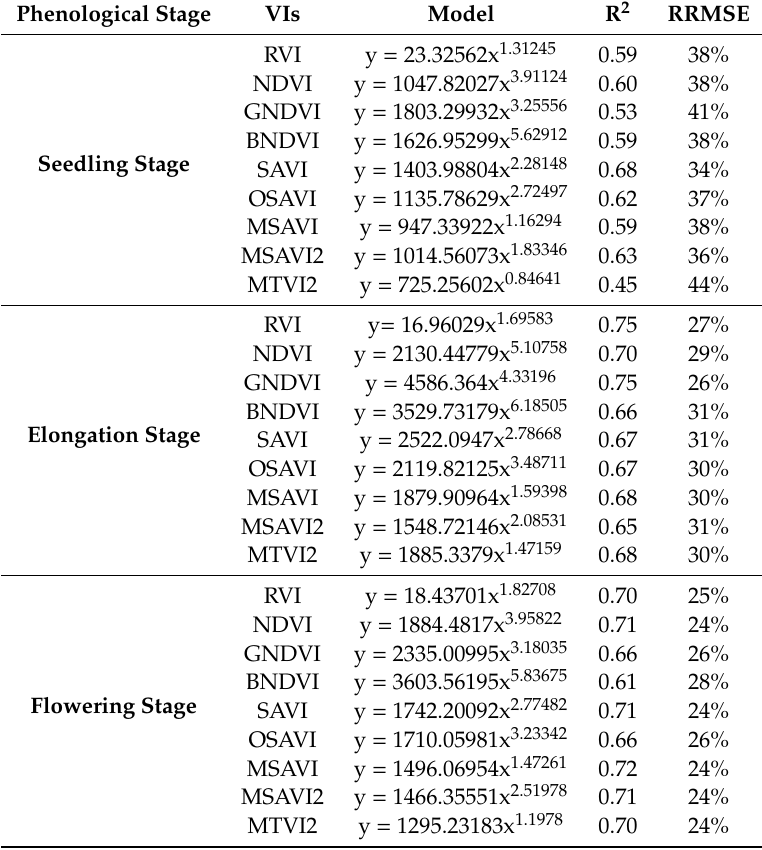
Table 5. Power function models and summary statistics of the relationship between LD and the explored VIs based on the calibration data set at di ff erent phenological